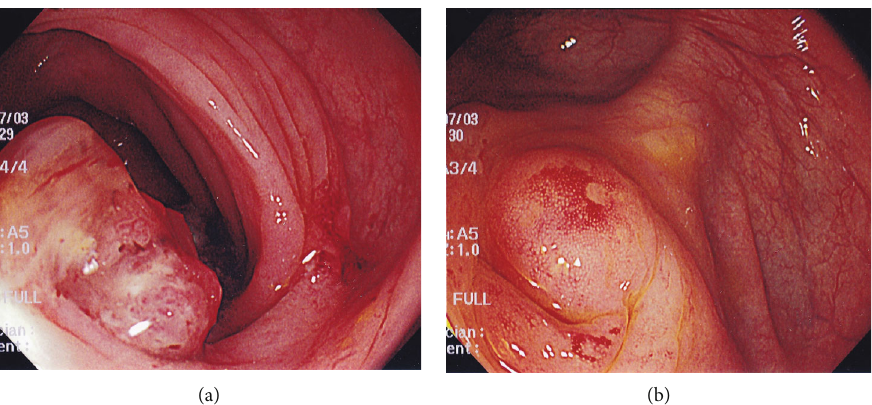
Figure 1: Colonoscopic fi ndings. (a) A polypoid-type tumor was seen in the sigmoid colon, which was initially assumed to be a sigmoid colon cancer. (b) An elevated lesion with redness was observed in the appendiceal ori fi ce, where biopsies were not performed.